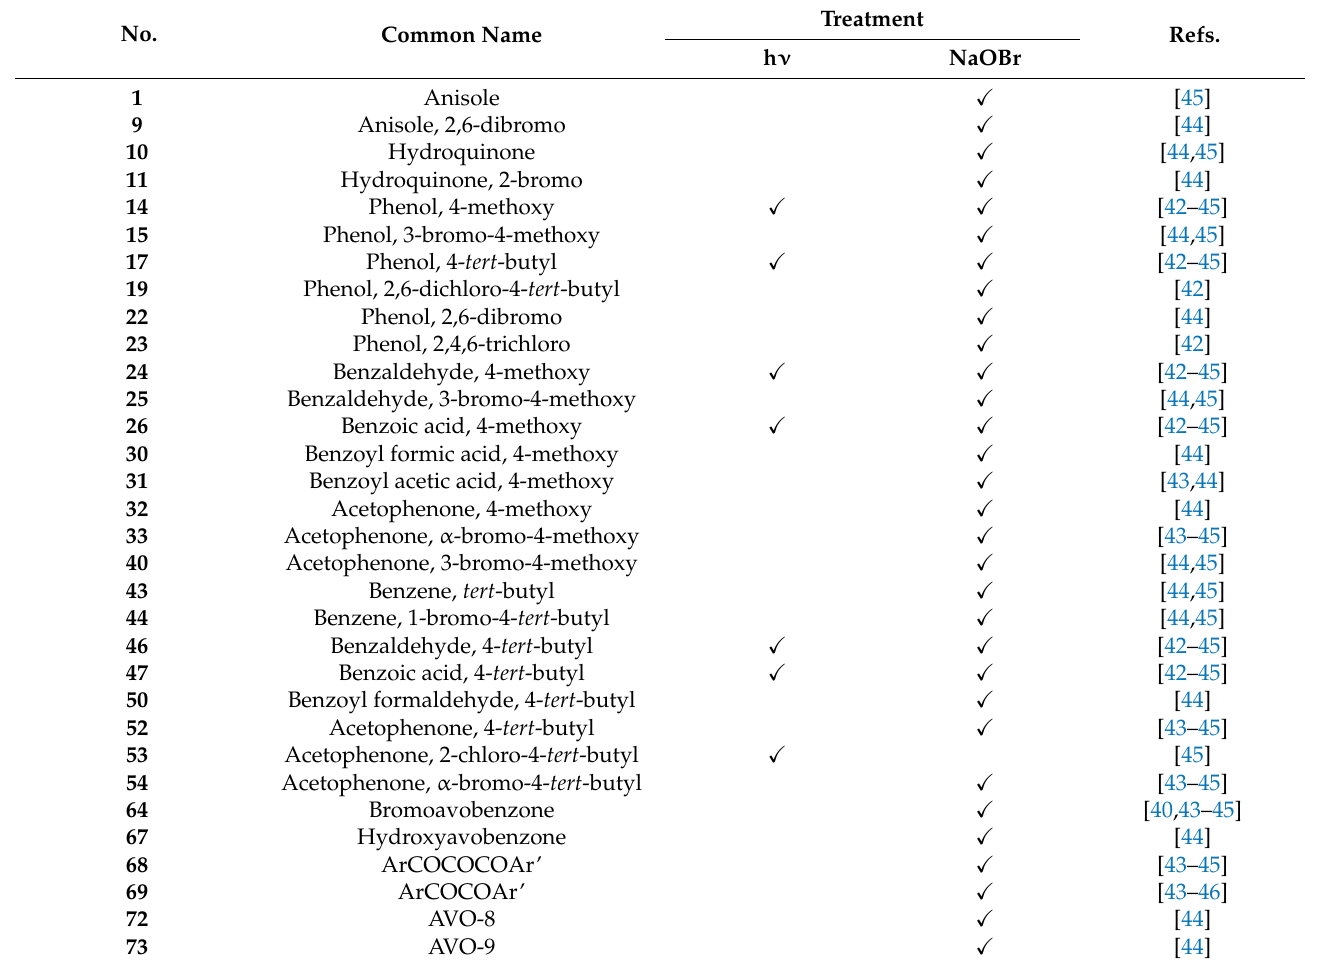
Table 4. Products obtained by UV irradiation and during a hypobromination process.